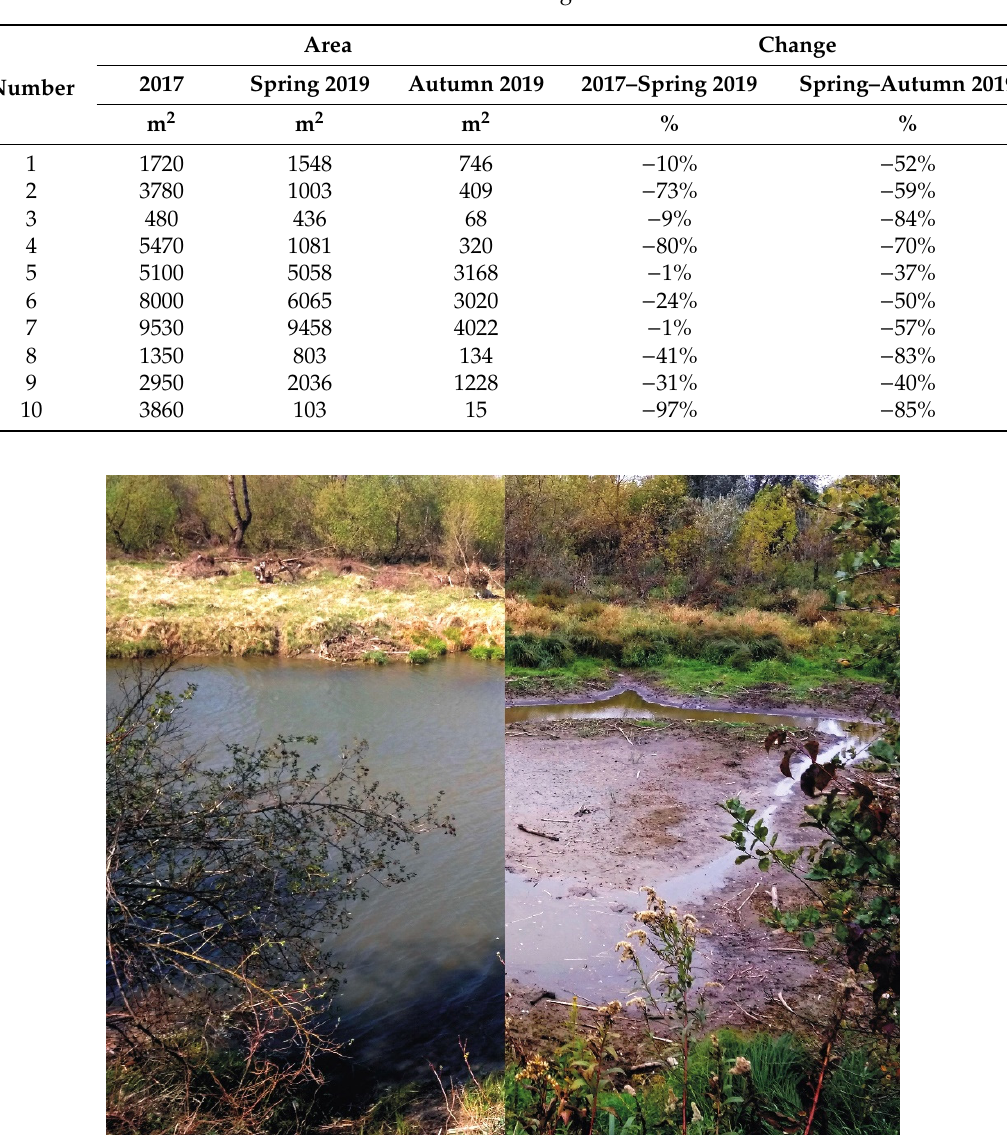
Table 3. Surface water area changes in the reservoirs.